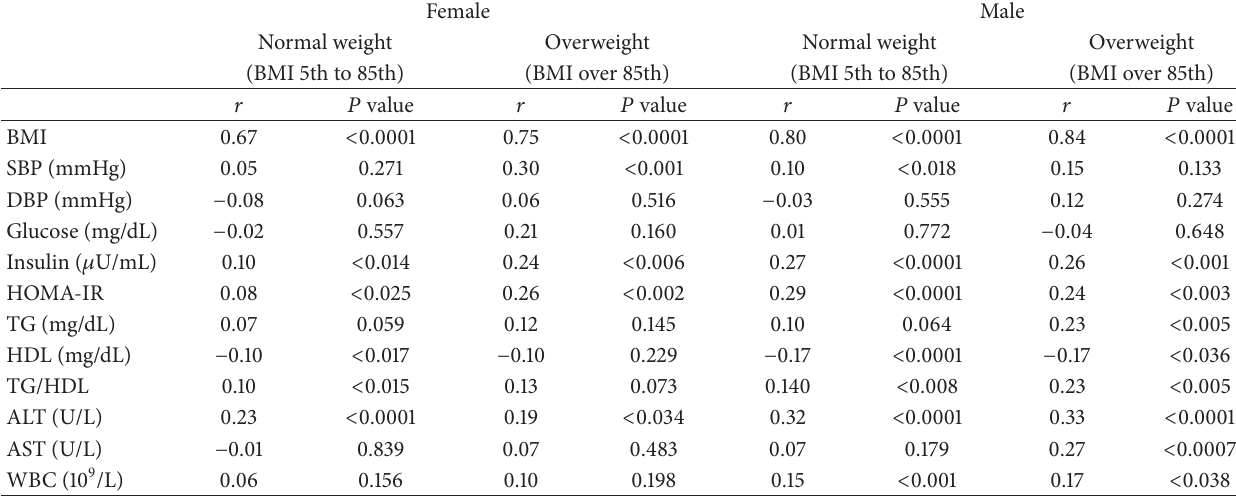
Table 4: Correlations between WHR and metabolic syndrome components of normal and overweight 13–18-year-old male and female adolescents. Female Male Normal weight Overweight Normal weight Overweight (BMI 5th to 85th) (BMI over 85th) (BMI 5th to 85th) (BMI over